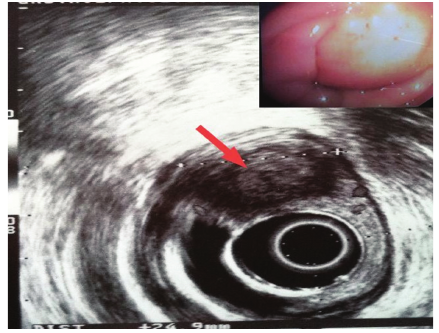
Figure 1: Pelvic MRI. Mass (red arrow) compressing intestinal lumen.